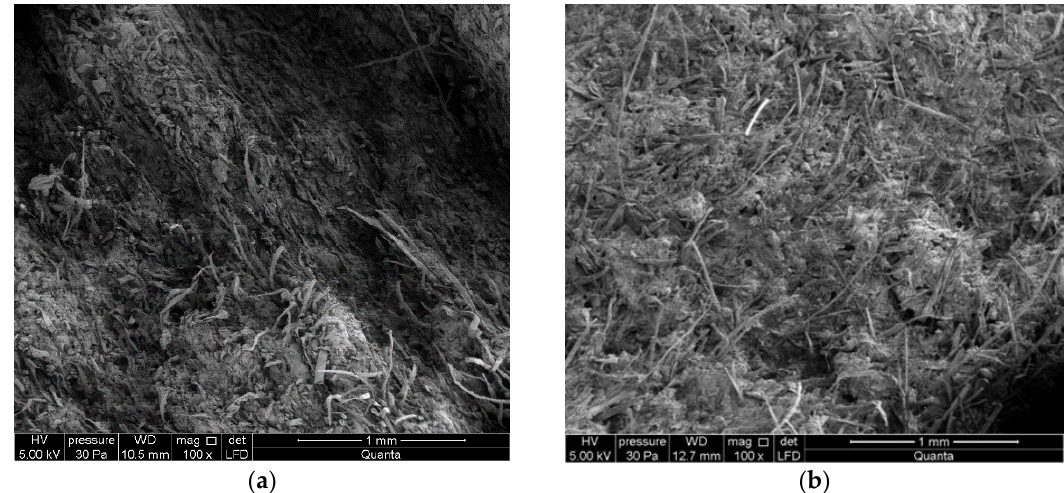
Figure 12. SEM images (magnification 100×) for ( a ) board A and ( b ) board D. Materials 2020 , XX , x FOR PEER REVIEW